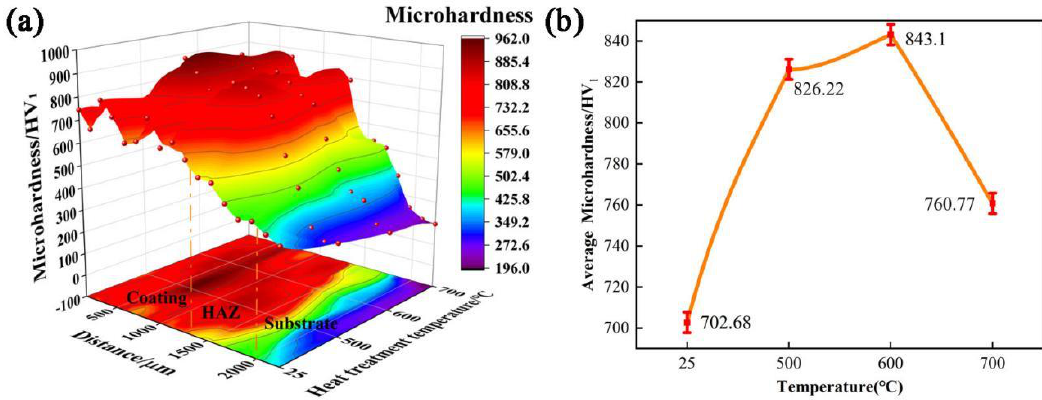
Figure 5. ( a ) Microhardness distribution of the composite coatings with different heattreatment tem- peratures; ( b ) average microhardness of the composite coatings with different heat-treatment temperatures.